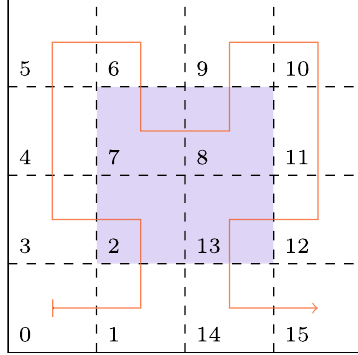
Fig. 5 Example of Hilbert curve and spatial intersection